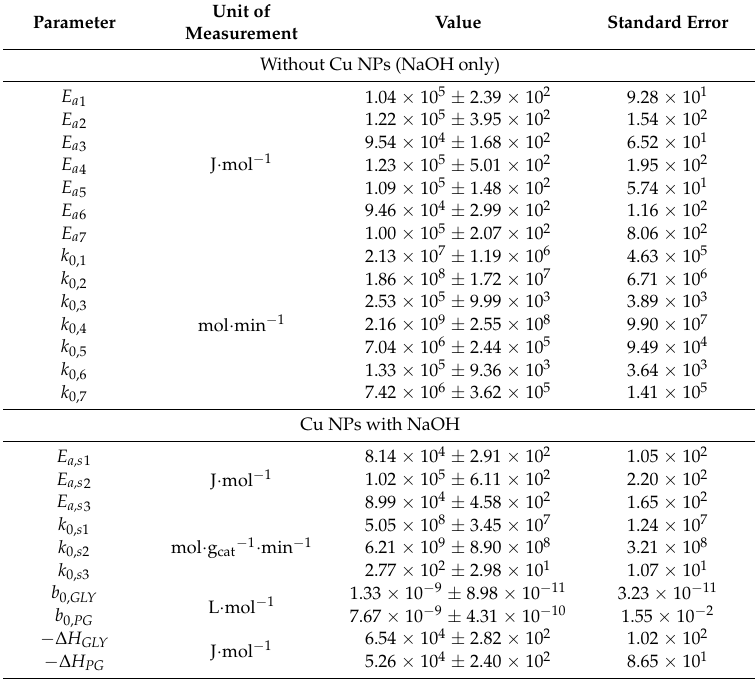
Table 7. The calculated values for the activation energies and pre-exponential factors.